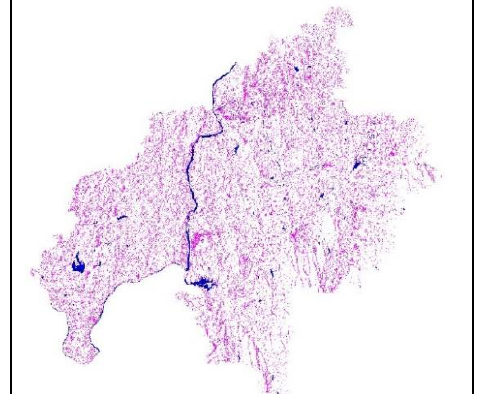
Figure 8. Residential area extraction based on SVM